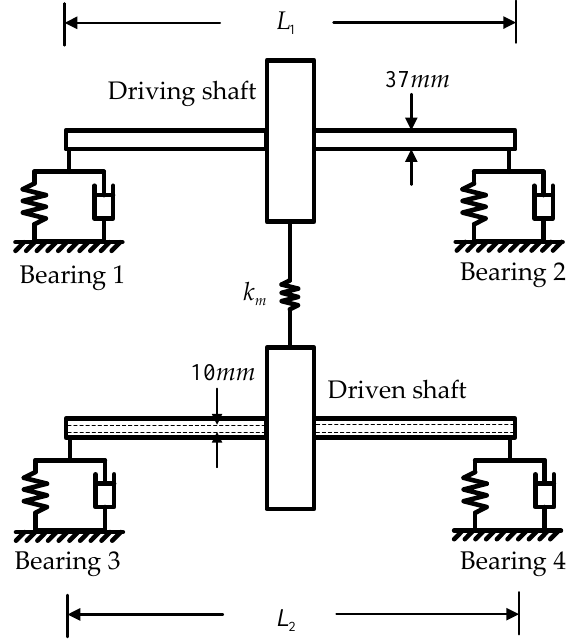
Figure 4. Gear mesh deformations from the proposed model.